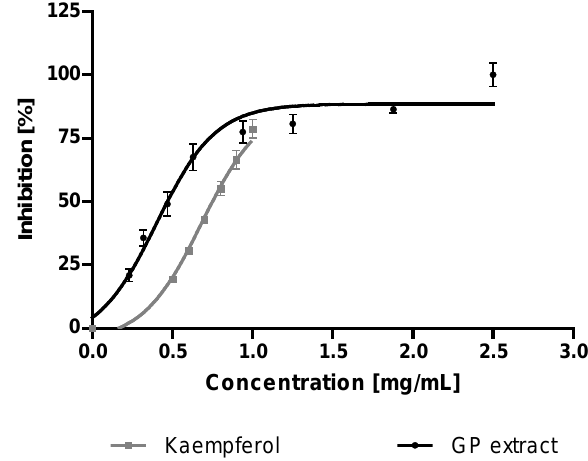
Figure 4. Anti-hyaluronidase activity of G. parviflora extract (GP) and the reference substance. Results are presented as mean values ± SD ( n = 3 × 2) represented by error bars, IC 50 , 50% inhibition of enzyme